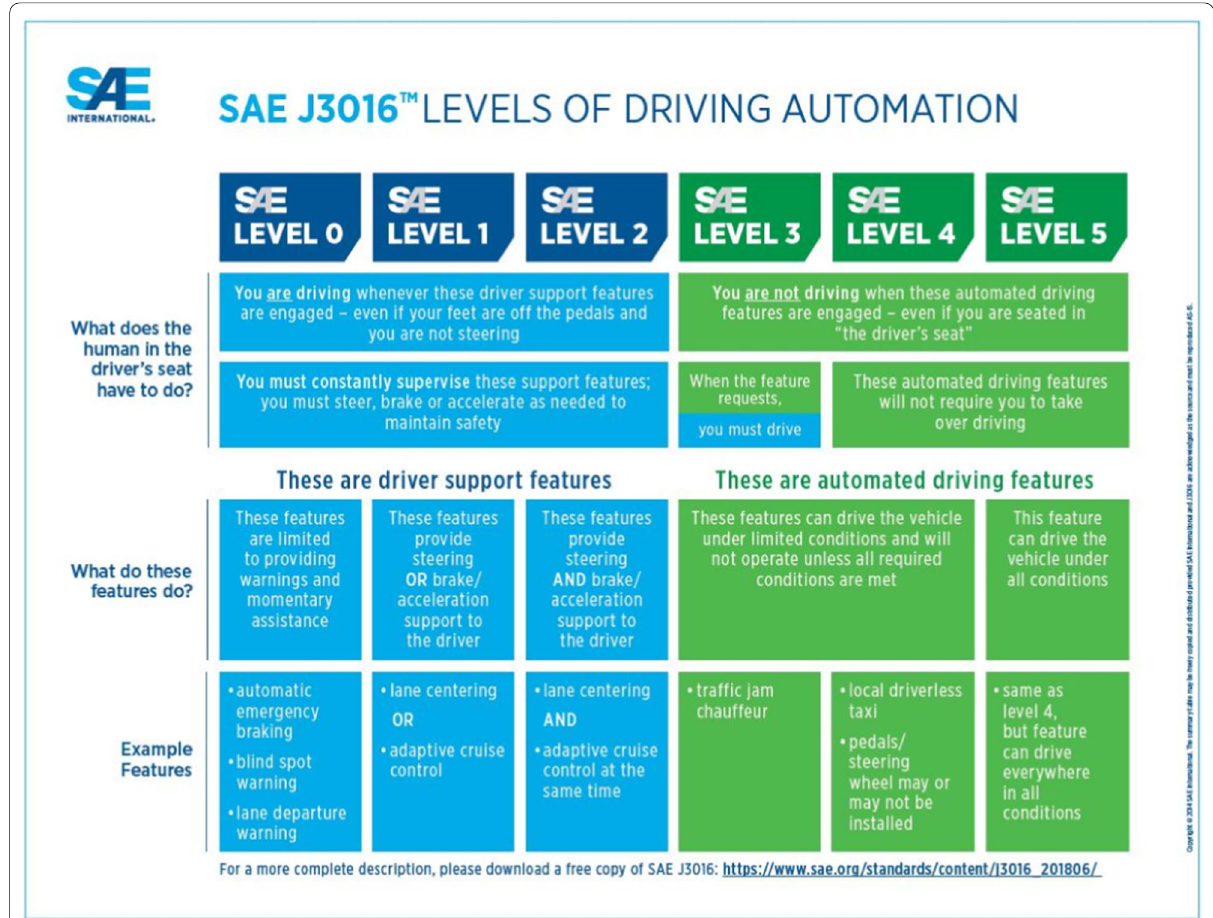
Fig. 1 SAE International’s (2016) six levels of automation for on-road vehicles, providing a universal taxonomy of terms for describing and defining levels of